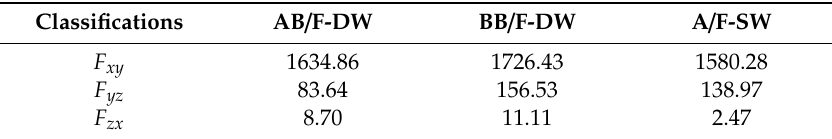
Figure 16. Directional reaction force for the unit cell of A/F-SW corrugated paperboard, they should be list as: ( a ) xy -direction; ( b ) yz -direction; ( c ) zx -direction. Table 7. Reactional forces (N) for 3 sub-problems.